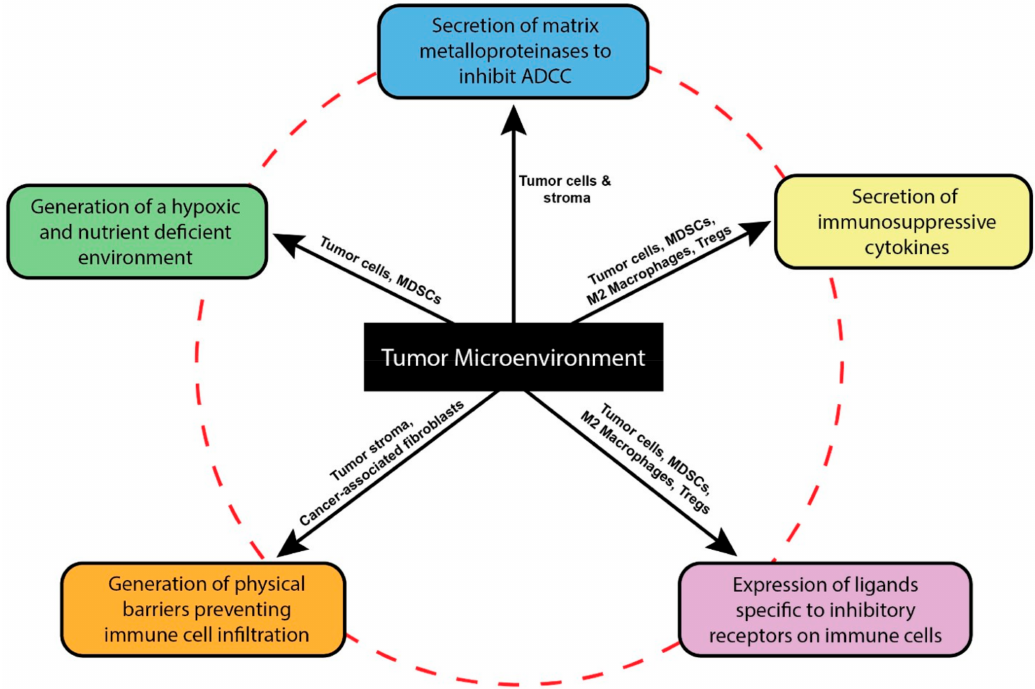
Figure 1. Features of the tumor microenvironment. Schematic depicting mechanisms by which components of the solid TME inhibit NK cell e ff ector functions. Inhibitory immune cells of the TME like MDSCs, Tregs and M2 macrophages secrete multiple inhibitory cytokines (yellow) and express ligands towards checkpoint receptors on NK cells (purple) to suppress their cytotoxicity. They aid tumor in generating a hostile surrounding by depleting the TME of essential amino acids while also promoting hypoxia (green). Tumor and stromal cells of the TME secrete matrix metalloproteinases that directly inhibit antibody-dependent cellular cytotoxicity of NK cells by cleaving NK Fc γ receptors thus rendering them ine ff ective (blue). Additionally, stromal cells, along with cancer-associated fibroblasts generate physical barriers that inhibits the infiltration capacity of tumor infiltrating NK cells